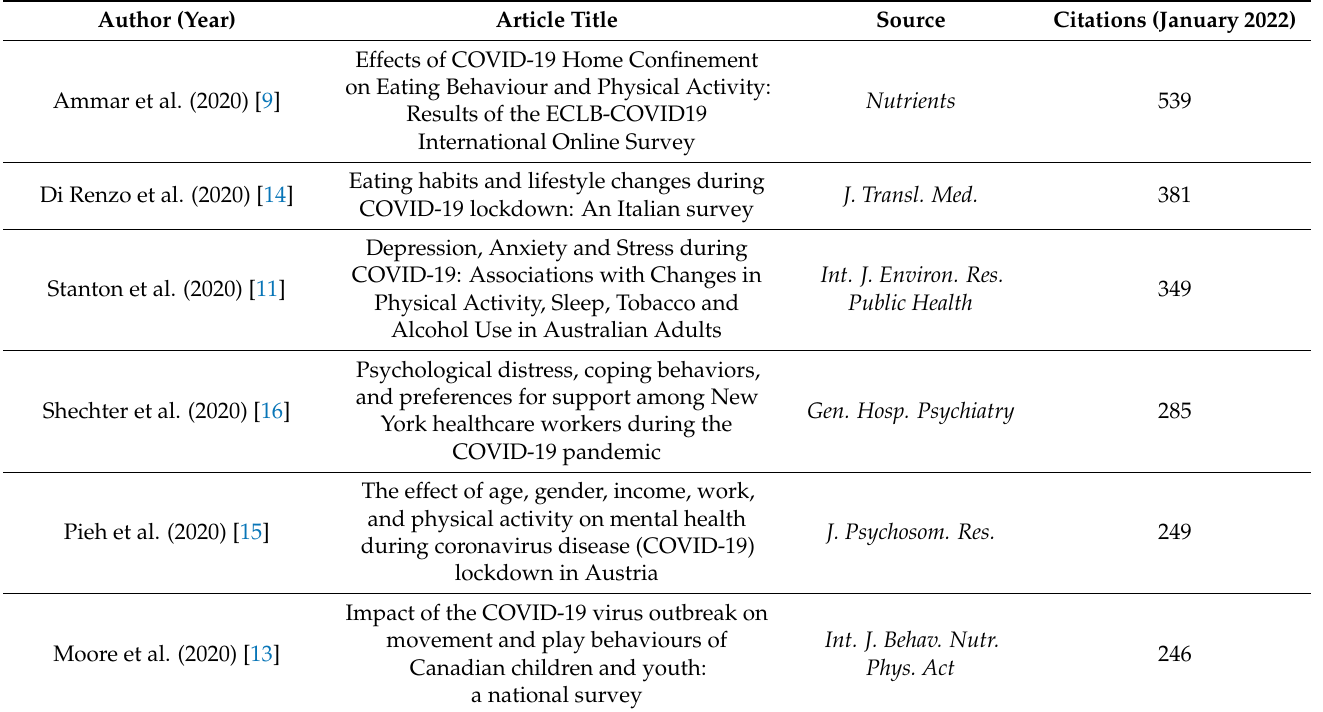
Table 5. Top 10 documents with the highest number of citations on physical activity and corona-virus disease